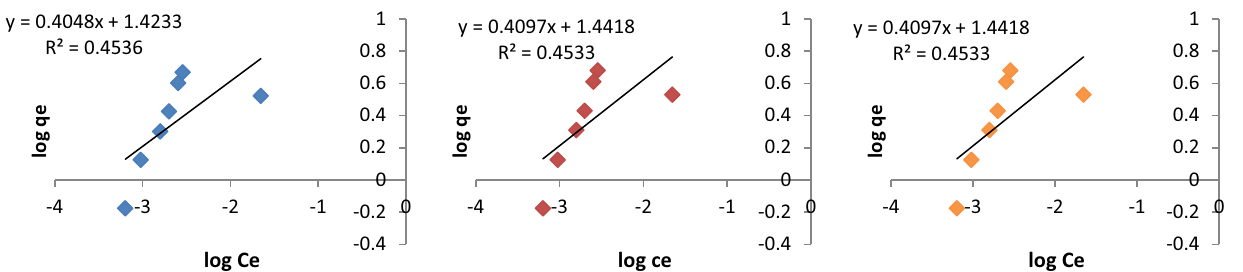
y = 0.4048x + 1.4233 R² = 0.4536